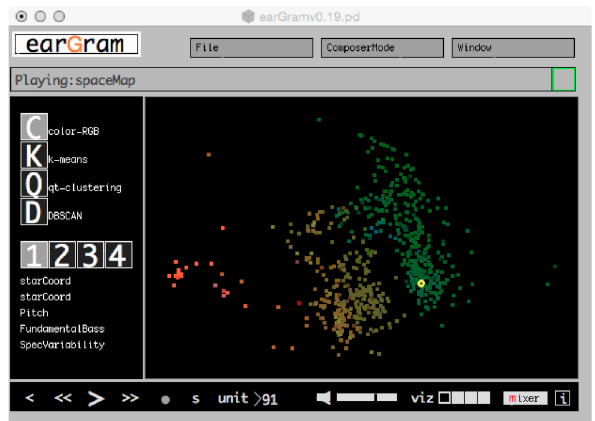
Figure 3 | 2D plot of the speech sound database used in the musical component of the